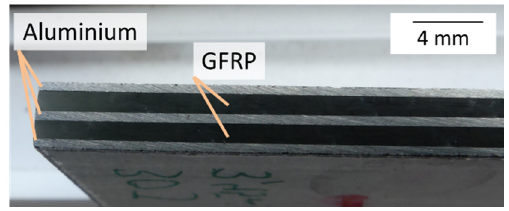
Figure 4. Cross section of the FML plate cut by waterjet.